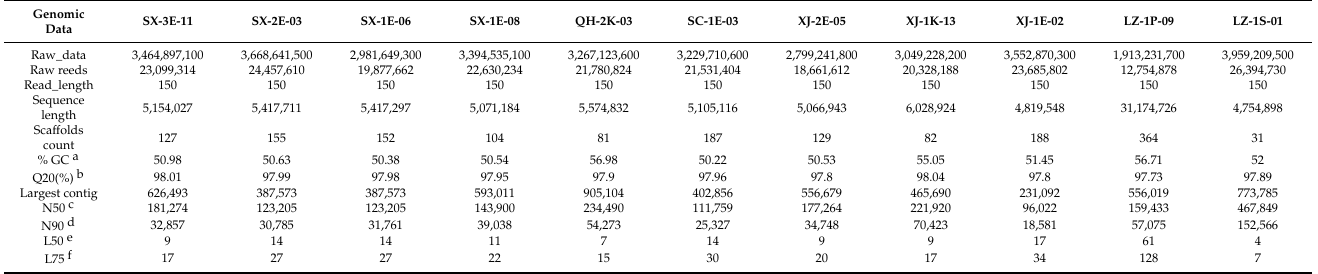
Table 3. The summary statistics of the assembled draft genomes of tigecycline-resistant